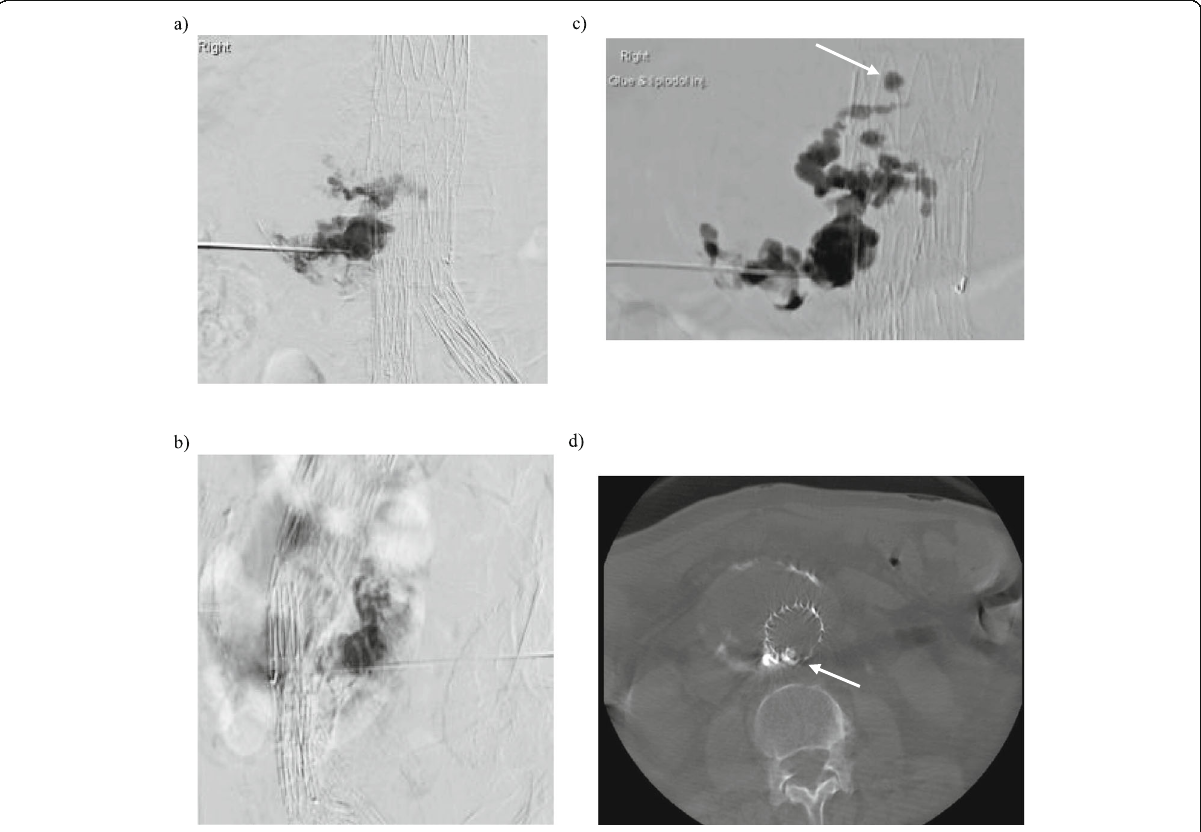
Fig. 2 a/b Prone PA and lateral digital subtraction angiogram of the abdominal aortic sac injection with iodinated contrast through a 20G access needle demonstrates filling of the aortic sac and no feeding artery. c Prone roadmap image of the aortic sac demonstrates filling of the sac with 4:1 Lipiodol/Glue mix (arrow) and penetration through the fabric into the lumen of the graft (arrow). d Axial non-contrast cone beam CT (prone) of the abdominal aorta demonstrates non-target embolisation in the body of the stent graft.